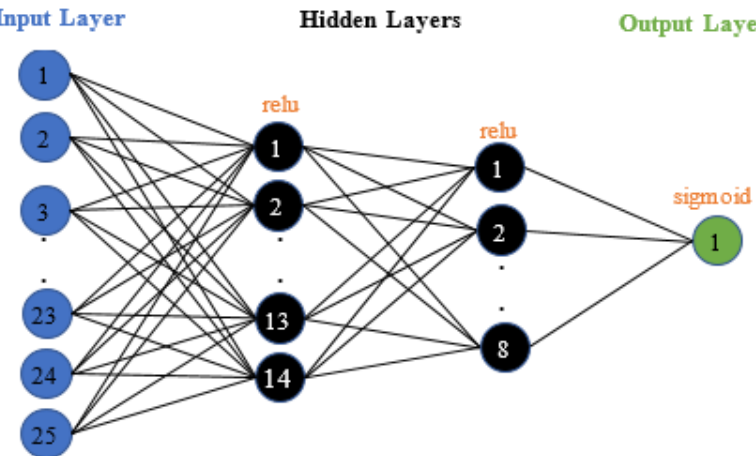
Figure 5. ANN model structure used in manual search case 2.